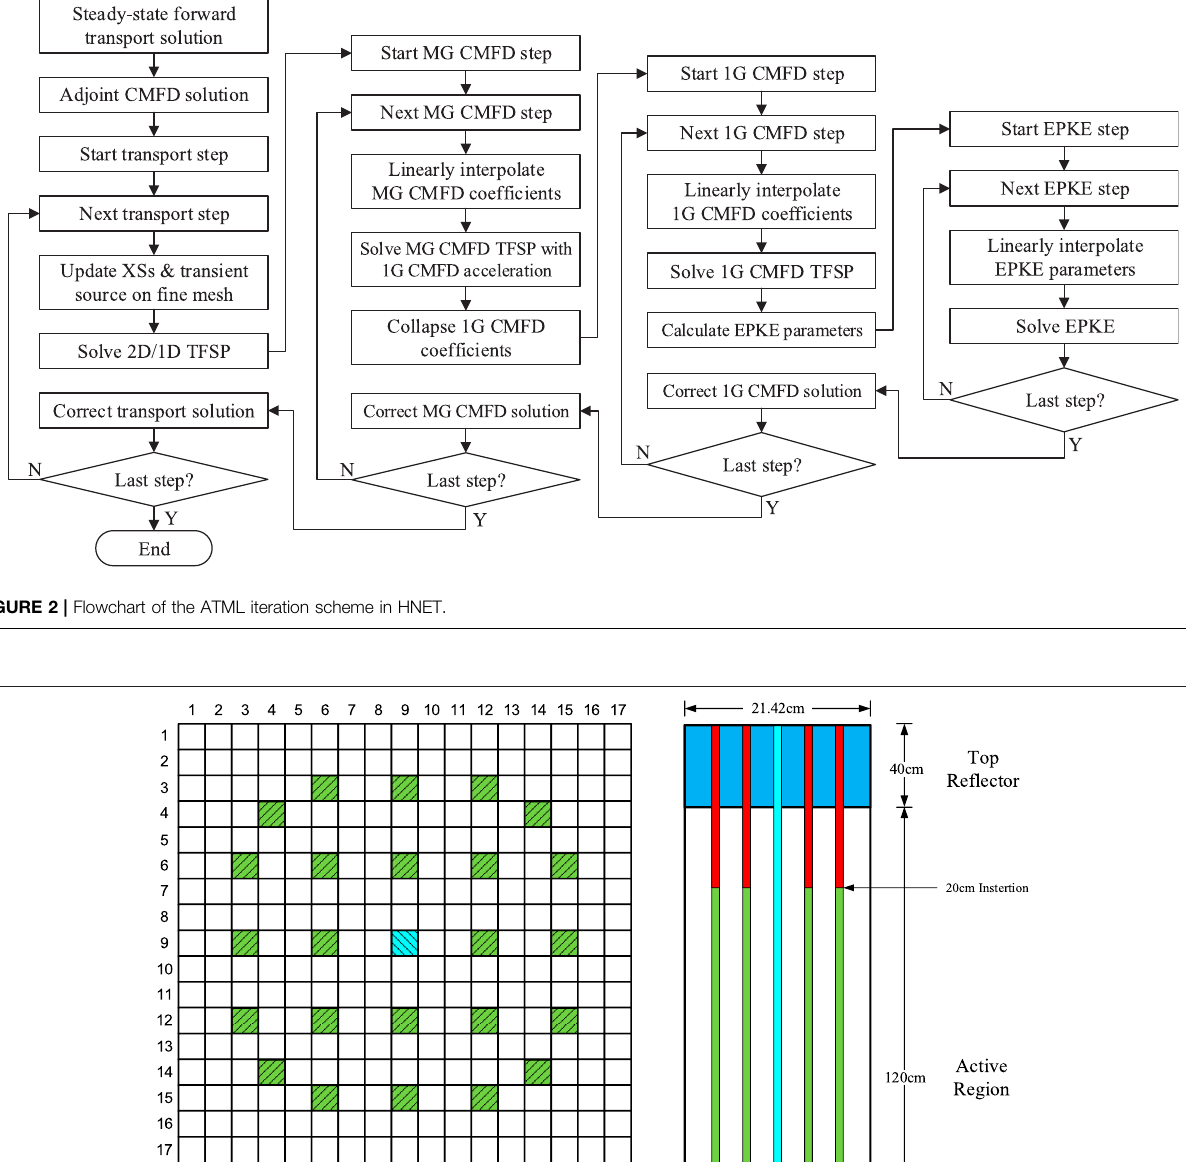
FIGURE 3 | Geometry con fi guration for Problem 1.